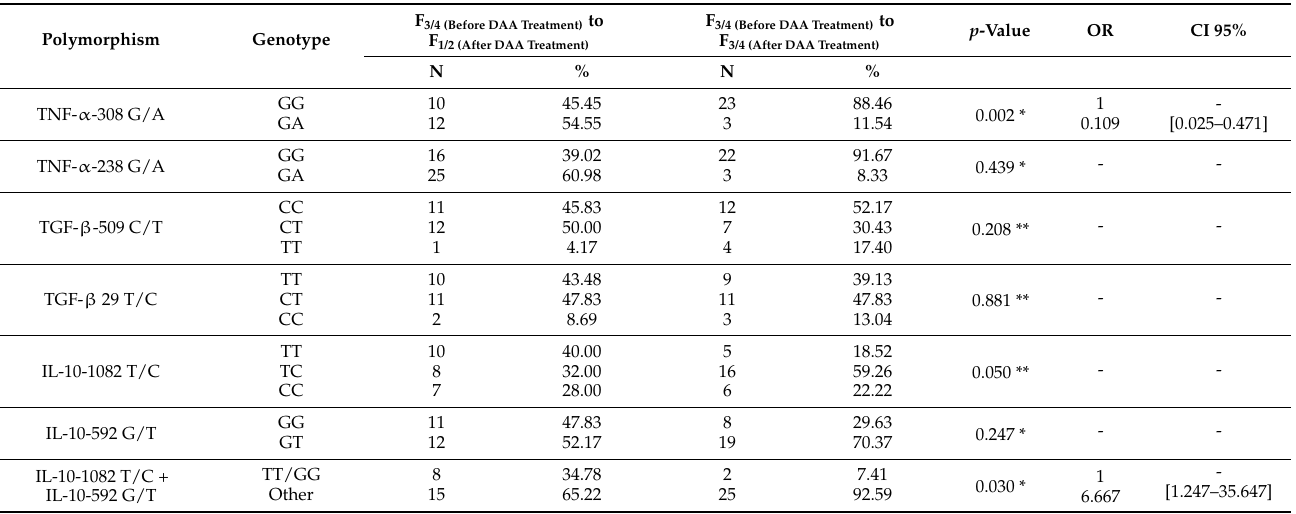
Table 8. Association of cytokine genetic polymorphisms and haplotypes with the improvement of fibrosis stage after DAA